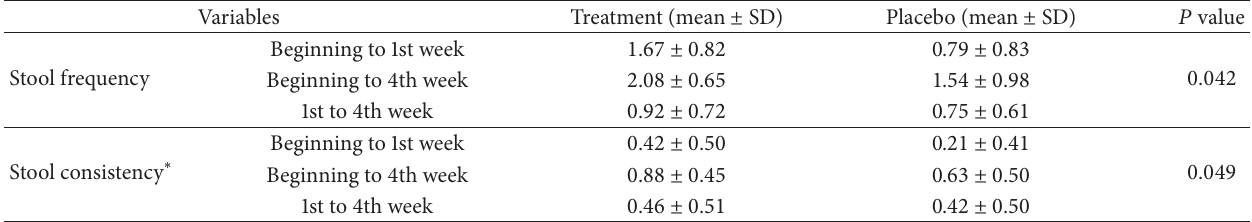
Table 2: Comparison of symptoms between the beginning and end of the 1st and 4th weeks.